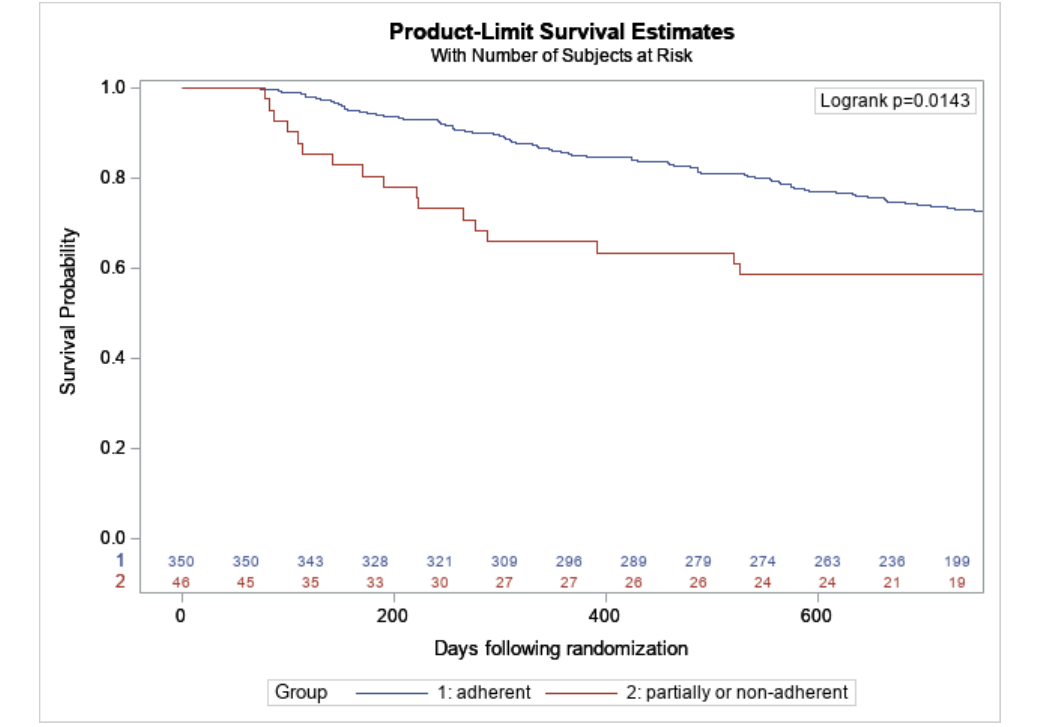
Figure 3. Kaplan–Meier probability of cardiovascular mortality or heart failure hospitalization in adherent patients vs. partially and non-adherent patients.